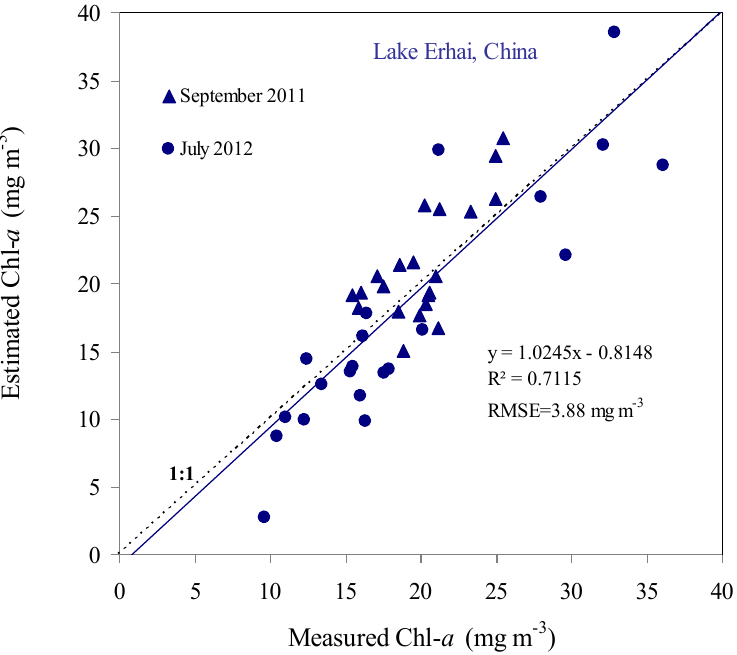
Figure 5. Comparison of the measured and estimated Chl- a by the SAMO-LUT for Lake Erhai, China.